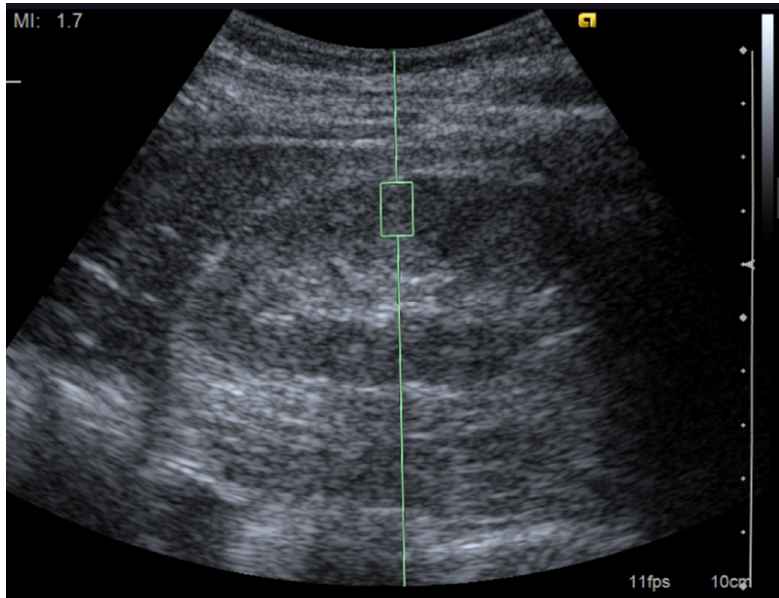
Figure 1. Image of a shear wave elastography measurement. Representative ultrasound image for the measurement of renal elasticity using a Siemens Acuson S2000 ultrasound system (Siemens, Erlangen, Germany) with convex probes (4C1, frequency range: 1–4 MHz) and a mechanical index of 1.7. The region of interest was set perpendicular to the renal capsule.